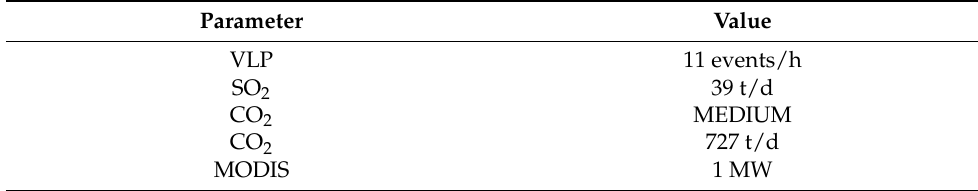
Table 3. Tagging of the main parameters from the daily LGS bulletin for 4 March 2021.